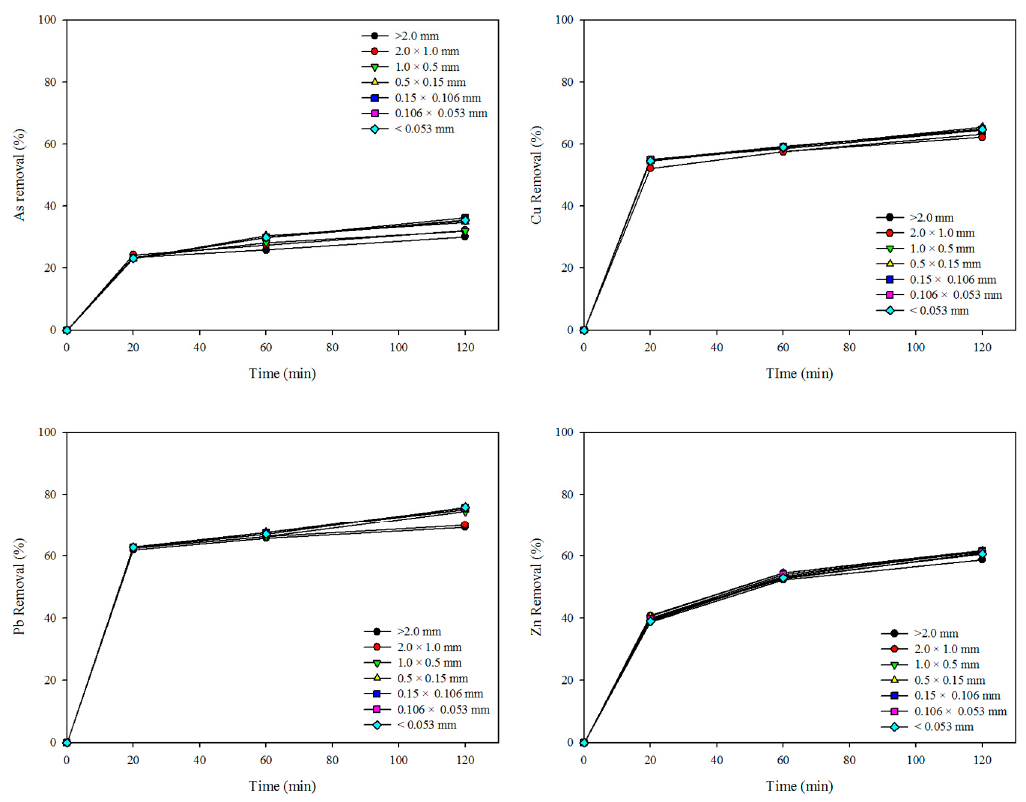
Figure A1. Effect of the size fraction on the extraction of As, Cu, Pb, and Zn from the batch test with 0.6 M sulfuric acid. Table A1. Summary of extraction parameters for As, Cu, Pb, and Zn using Equation (2) with sulfuric